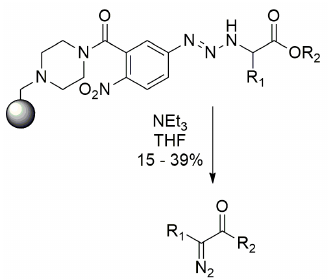
Figure 42 - Fragmentation of a triazene derivative under basic conditions.